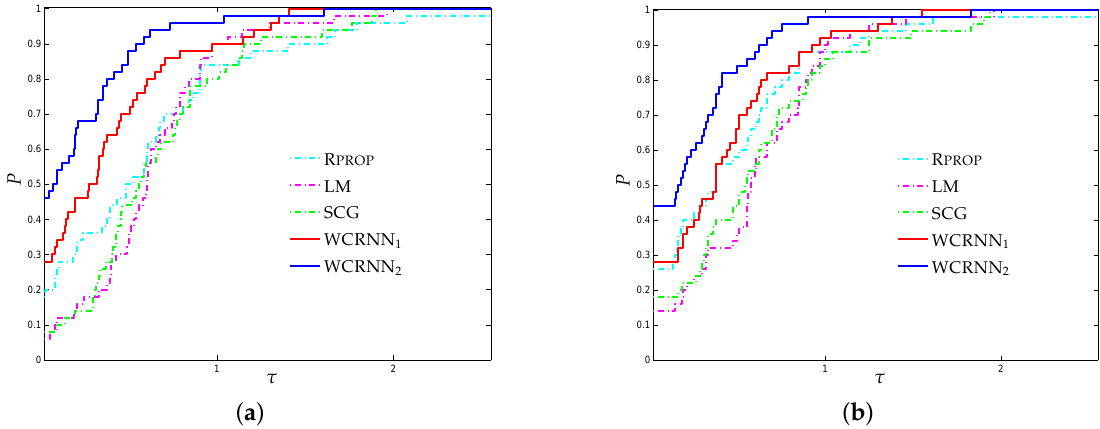
Figure 2. Log 10 -scaled performance profiles for the German credit approval classification problem. The performance profile plots, for every τ ≥ 1, the proportion P ( τ ) of simulations for which any training algorithm has a performance within a factor τ of the best algorithm. ( a ) F 1 -score. ( b )